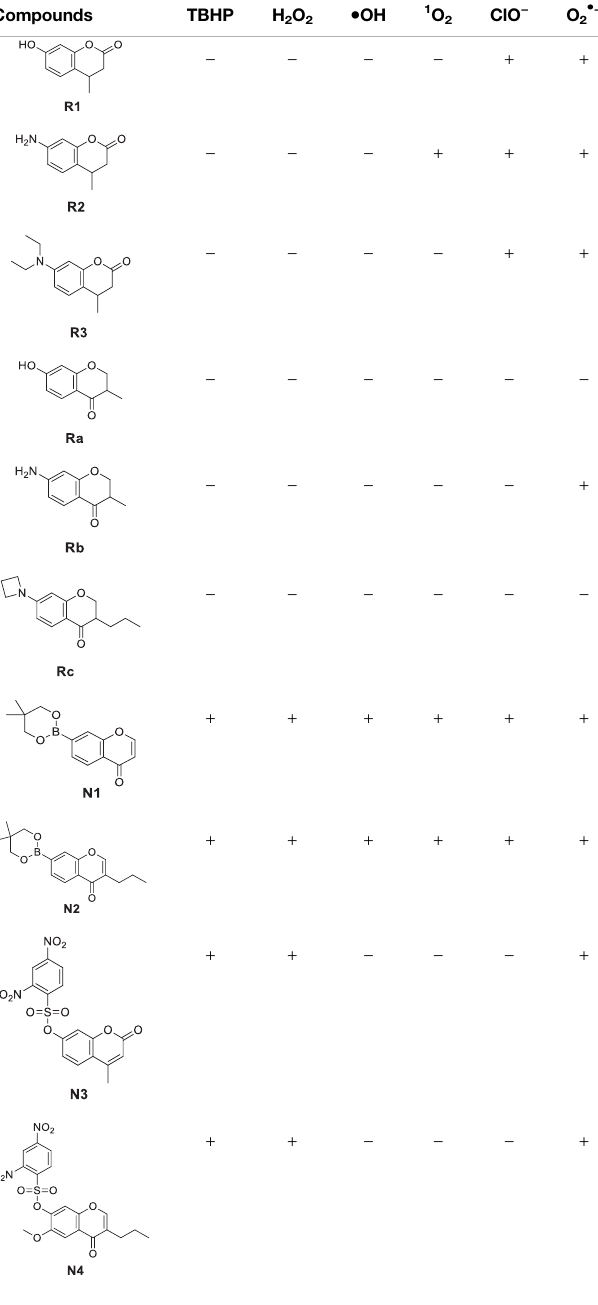
TABLE 2 | The reactivity between the probes and various ROS.